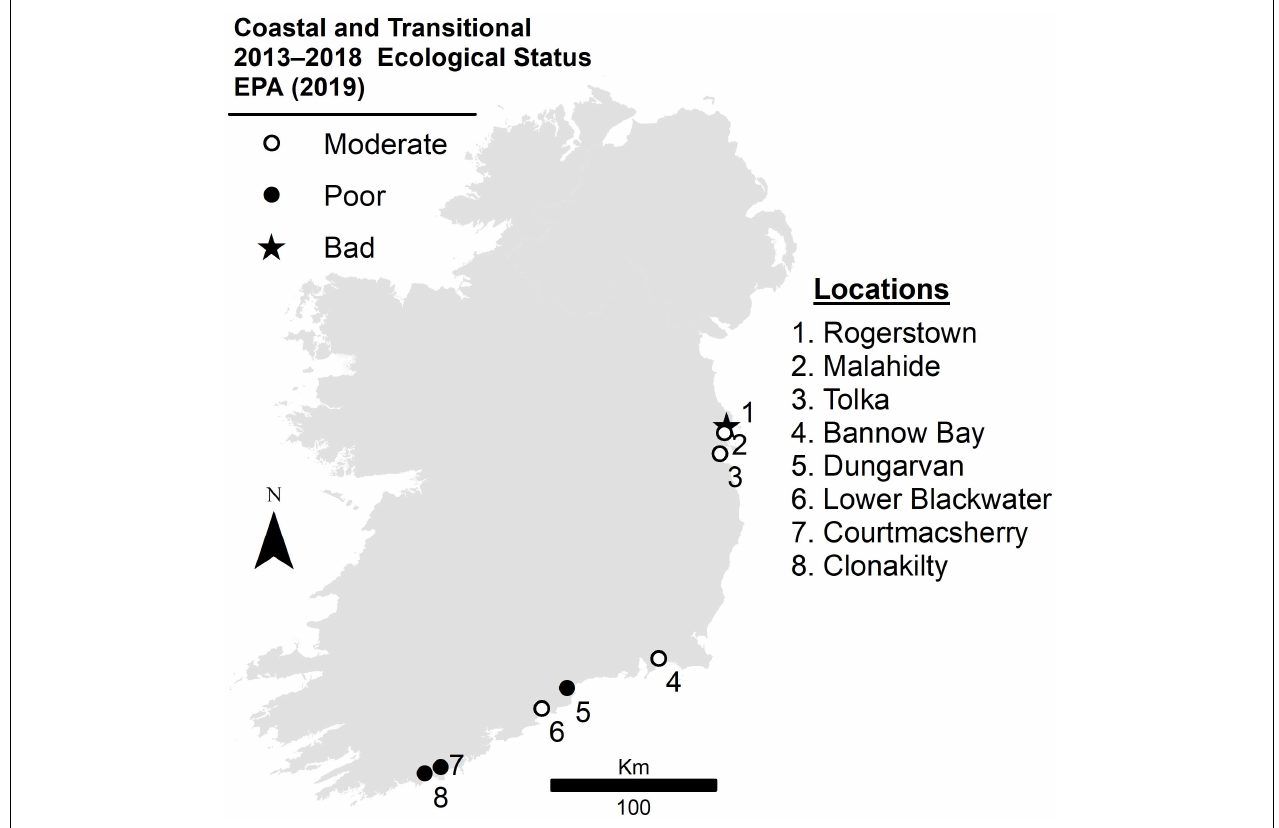
FIGURE 1 | Map of Ireland showing eight estuarine areas considered in this study with their ecological status based on the study conducted from 2013 to 2018 (EPA, 2019).